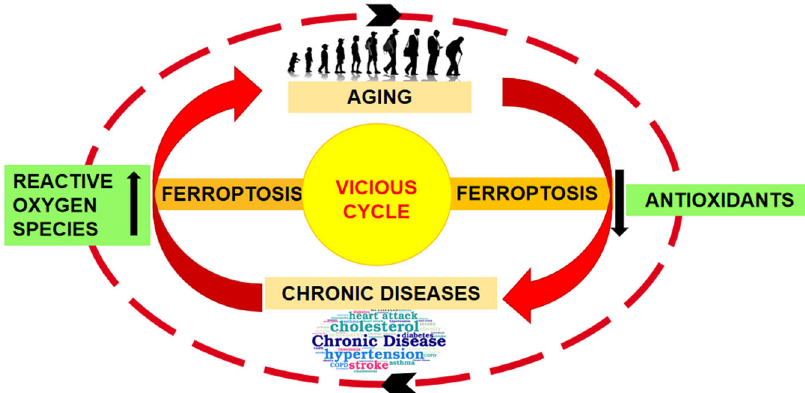
Fig. 1 A vicious cycle of aging mechanism, promoted by underlying chronic diseases and ferroptosis. Illustration showing ferroptosis as a catalytic factor for induction of a vicious cycle of accelerated aging and chronic disease progression with underlying imbalance of oxidant and antioxidant defense